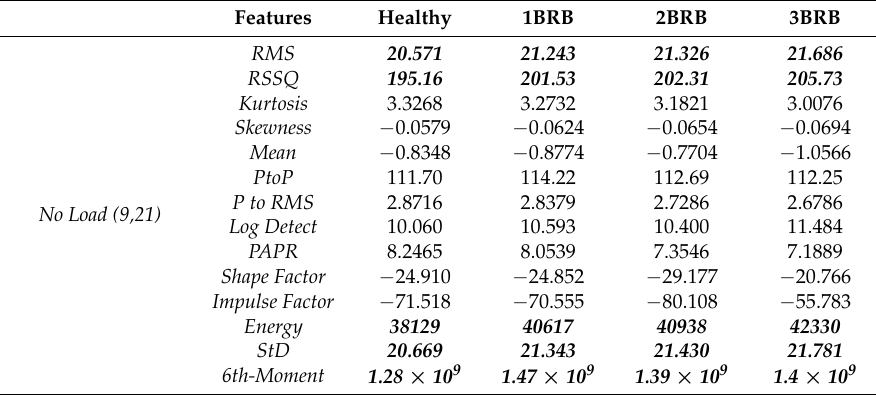
Table 6. Mean Value of Statistical Features for Healthy and Faulty Motor in No Load.